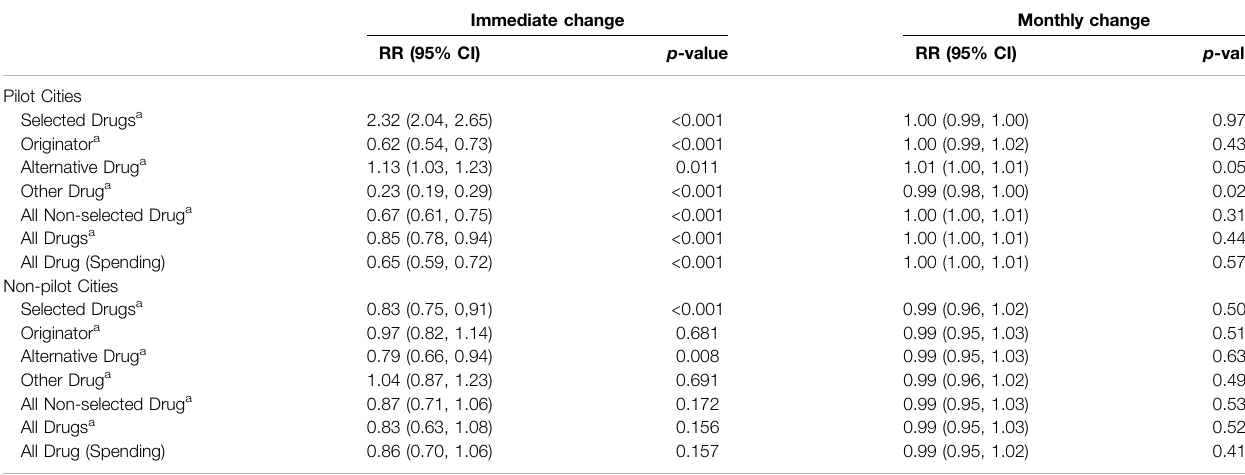
TABLE 1 | Interrupted time-series regression model